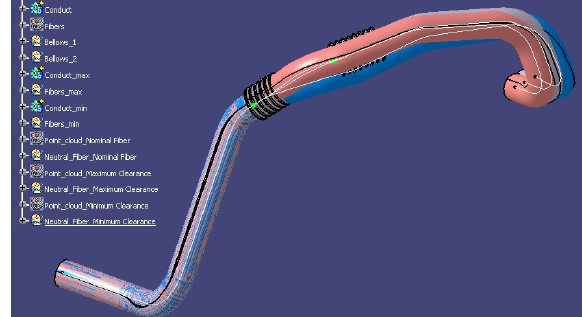
Fig. 10. Conduct generated with the CATIA V5 optimization module and MATLAB